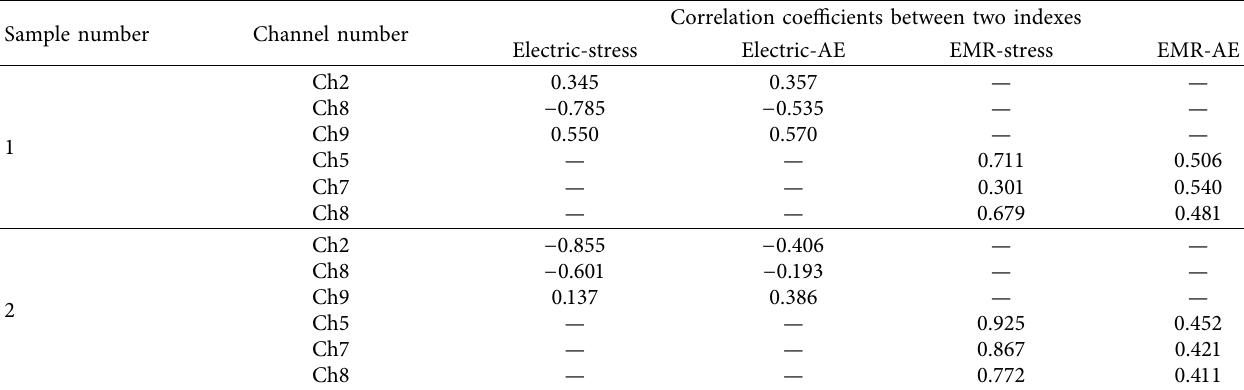
Table 1: Statistics on correlation coefficient values between two indexes of electric-magnetic signals as well as stress and AE energy. Sample number